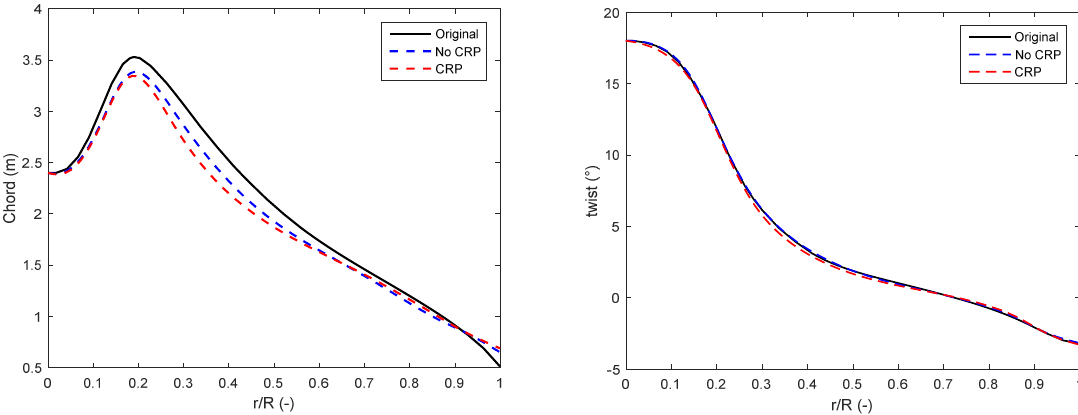
Figure 12. The comparison of chord and twist distributions between the optimal blades and the original one.